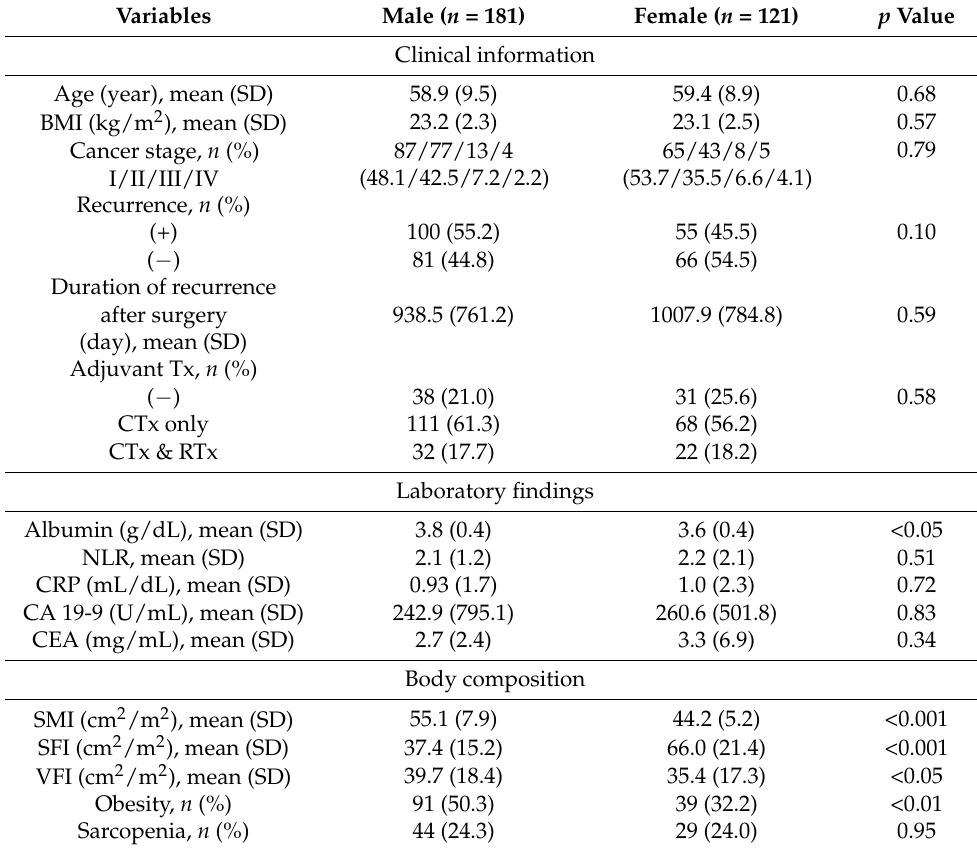
Table 1. General characteristics of the